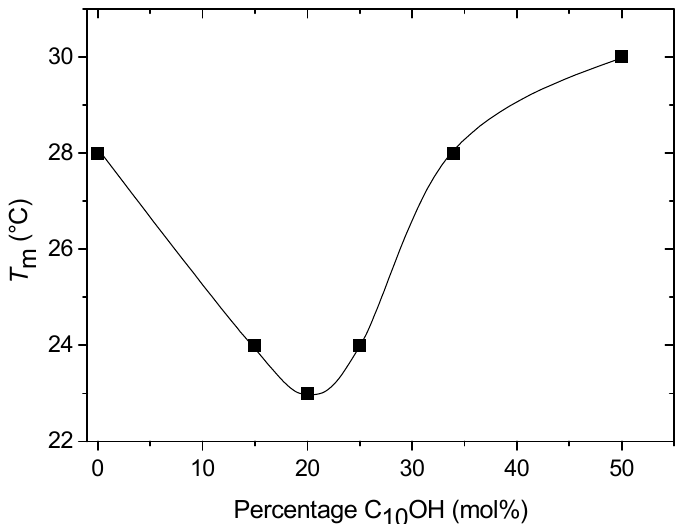
Figure 6. Relationship between T and the percentage of C m OH mixtures. The line is drawn to guide the DHAB/C 10